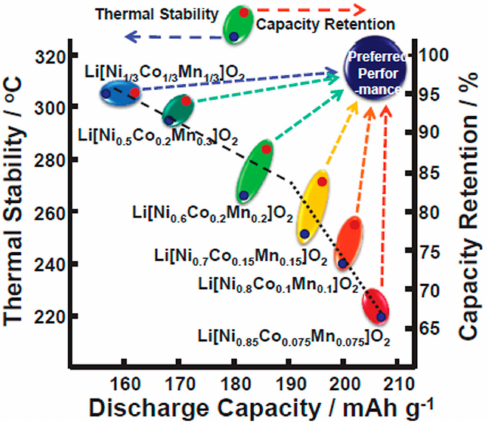
Figure 4. The relationship between discharge capacity, thermal stability and capacity retention of Li(Ni 1 − x − y Co x Mn y )O 2 (Reproduced from [5], Copyright 2013, with permission from